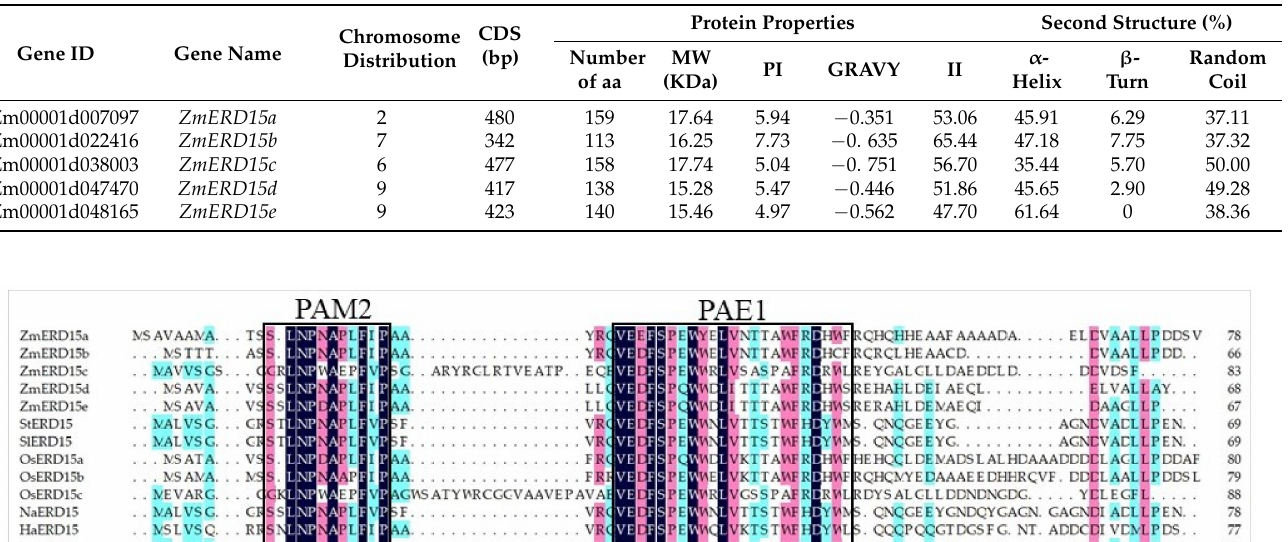
Table 1. The ZmERD15 members in maize.